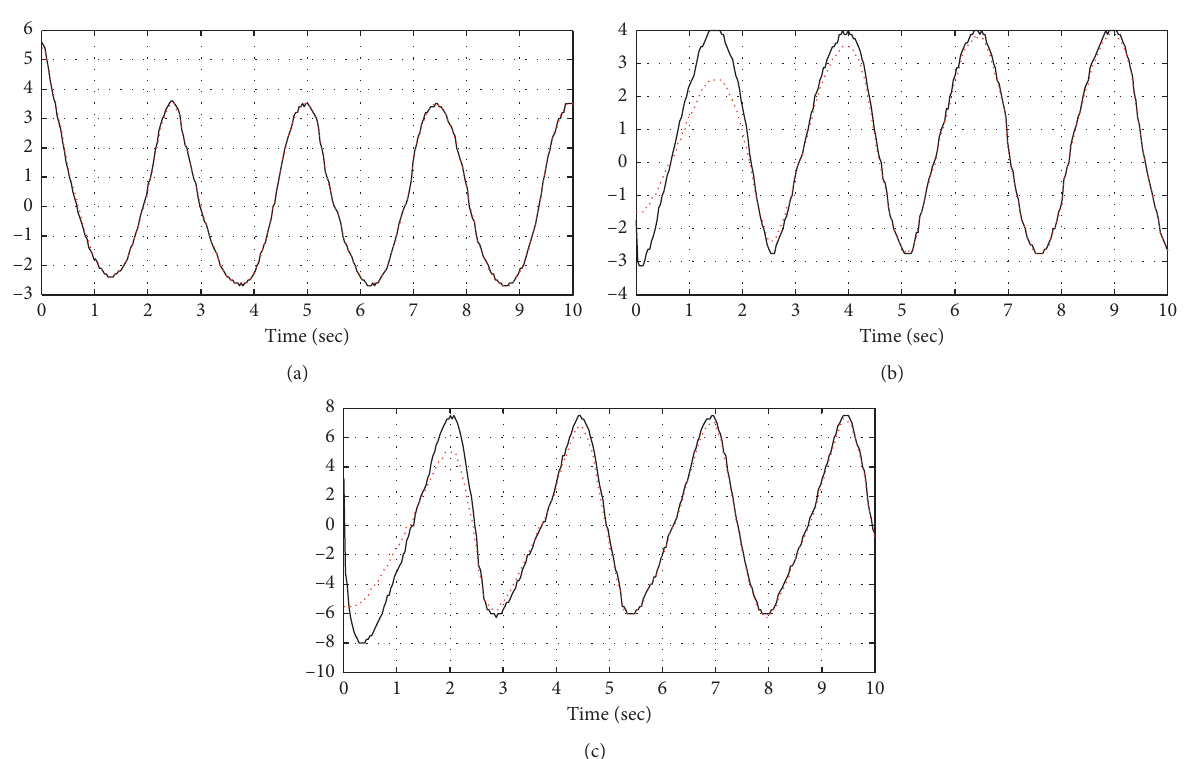
, (b) x and 􏽢 x and 1 1 2